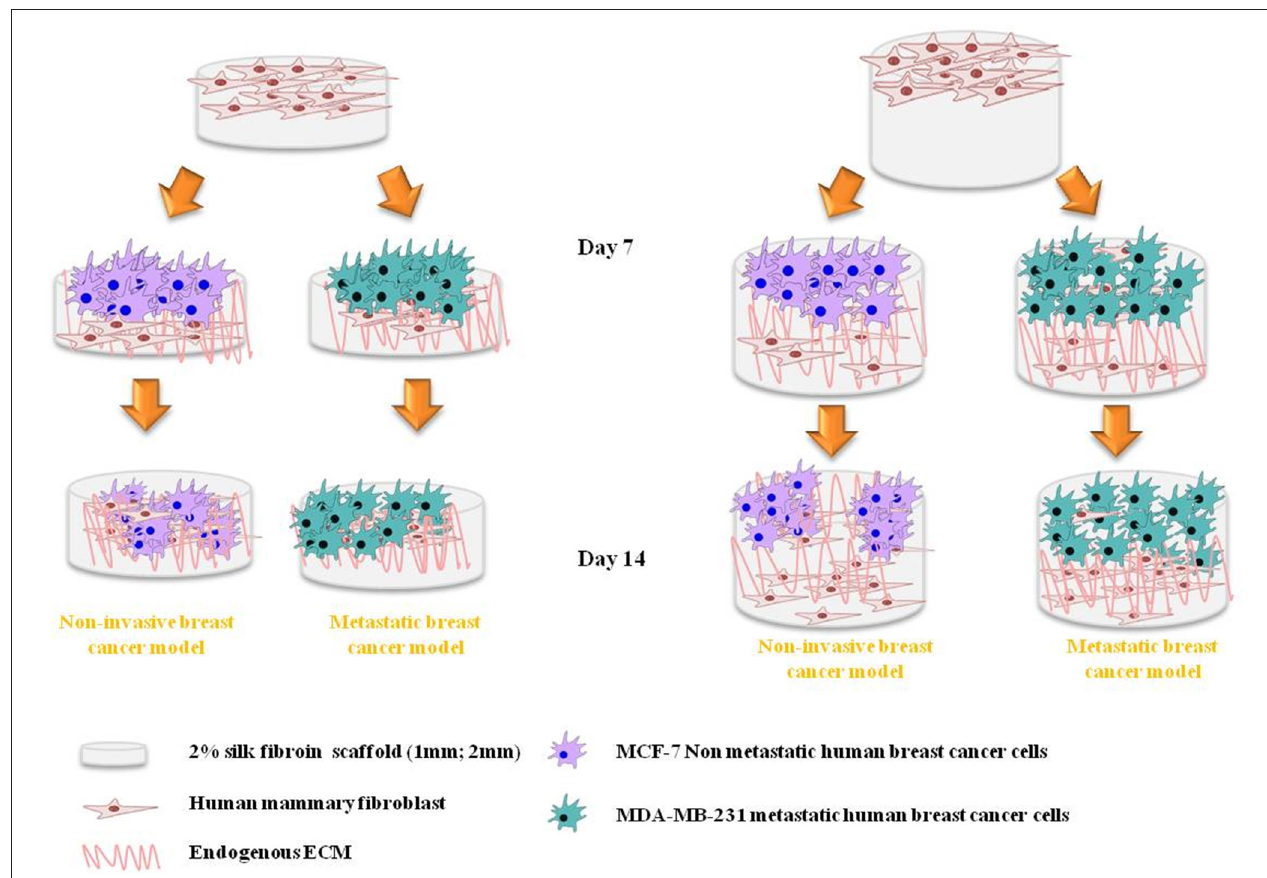
FIGURE 1 | Schematic representation of the in vitro cell culture approach using silk protein fibroin (SF) biomaterial to obtain 3D breast cancer model. Silk fibroin scaffolds of two different thicknesses support the growth of breast cancer cells co-cultured with mammary fibroblasts. The cancer cells were seeded 7 days after the fibroblasts seeding. Four different co-cultured conditions were analyzed in this work: 3D-HMF/MCF7 in 1mm and 2mm SF scaffold, 3D-HMF/231 in 1mm and 2mm SF scaffolds.